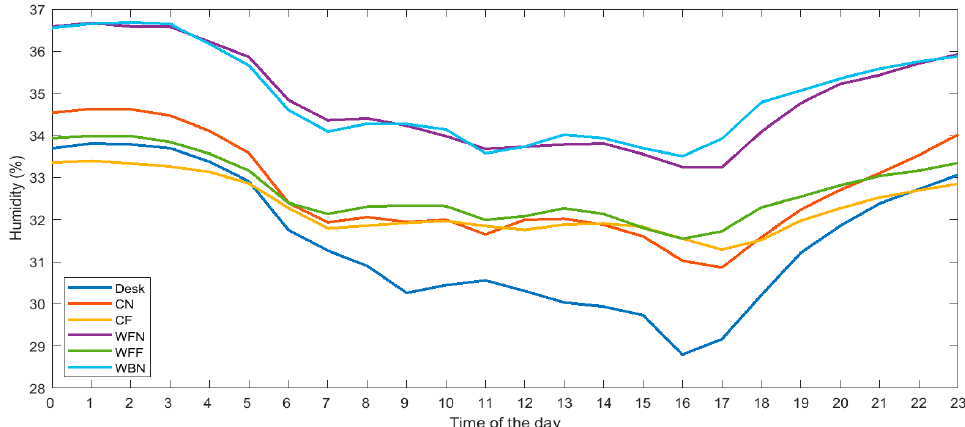
Figure 9. Time series of humidity sensors with various positionings.